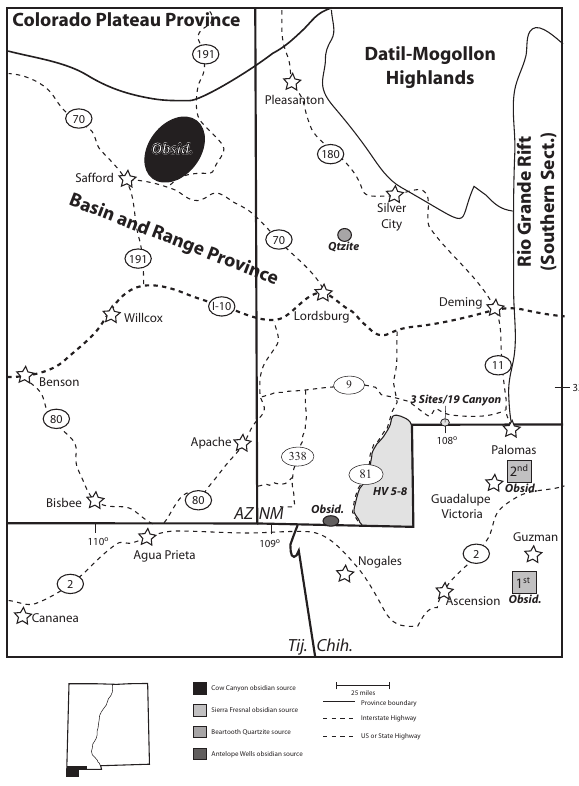
Fig. 1. Location of the study area in regional context. Known loca- tions for distinct geologic materials are indicated by shaded areas.